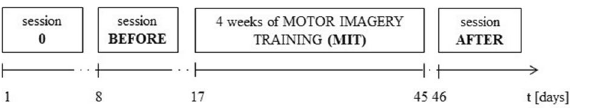
Figure 1. Scheme of the experimental protocol, consisting of familiarization session 0 and two similar measurement sessions before and after motor imagery training.